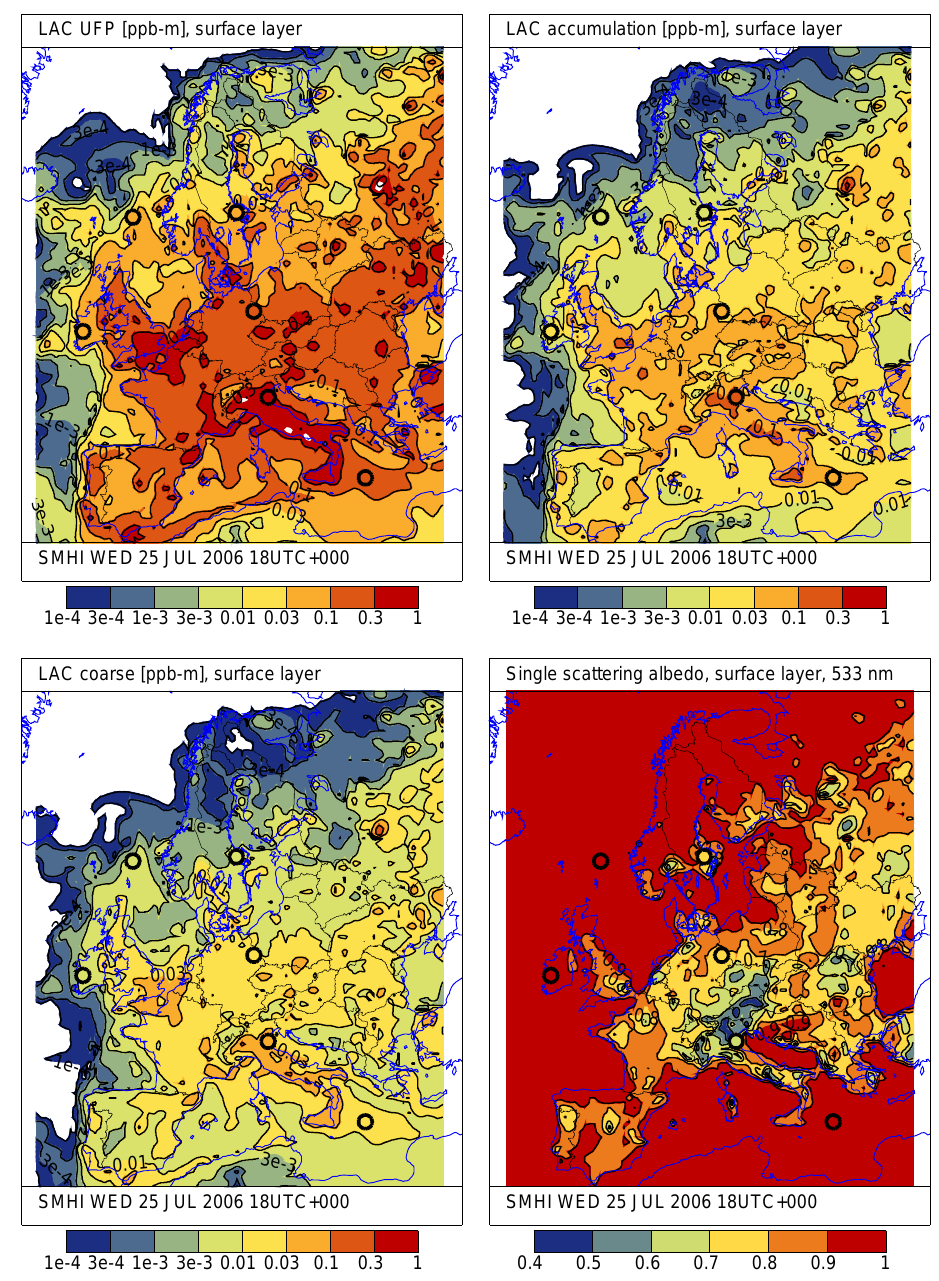
Fig. 3. Black carbon mass mixing rations ( µ g/kg) for size bins with diameters < 100nm (upper left), 100nm–1µm (upper right), and > 1µm (lower left), as well as single scattering albedo ω (lower right) at λ =533nm. The maps show results for 25 July 2006 18:00UTC in the model layer closest to the surface. Also indicated are six locations chosen for radiative transfer case